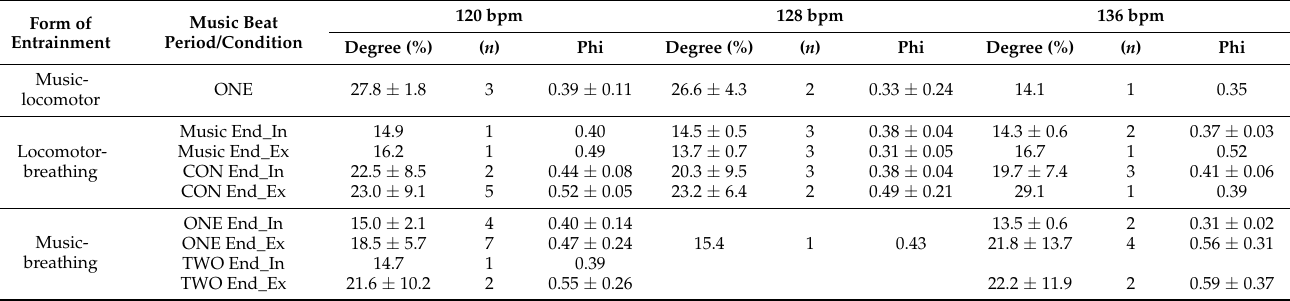
Table 3. Presence, degree, and magnitude of entrainment for the music-locomotor, locomotor- breathing, and music-breathing entrainment analyses, when considering the three levels of music tempo separately.